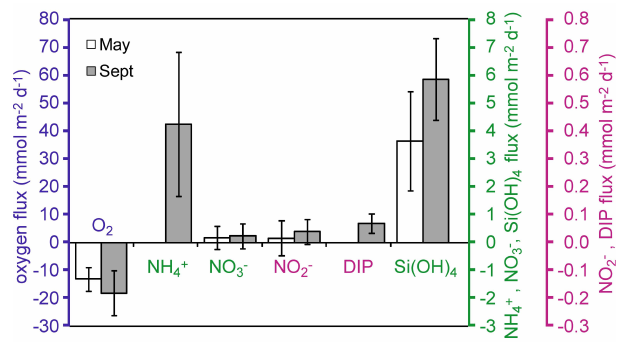
Fig. 24. Mean values of in situ and ex situ benthic total oxygen uti- lization (mmolm − 2 d − 1 ) and benthic nutrient fluxes in May 2010 ( n = 6) and September 2010 ( n = 7) measured at the site of the RCM mooring at Portita on the northwestern Black Sea shelf. Error bars represent the standard deviation of the flux measurements from the calculated mean value. Ammonia and phosphate fluxes in May were below their respective detection